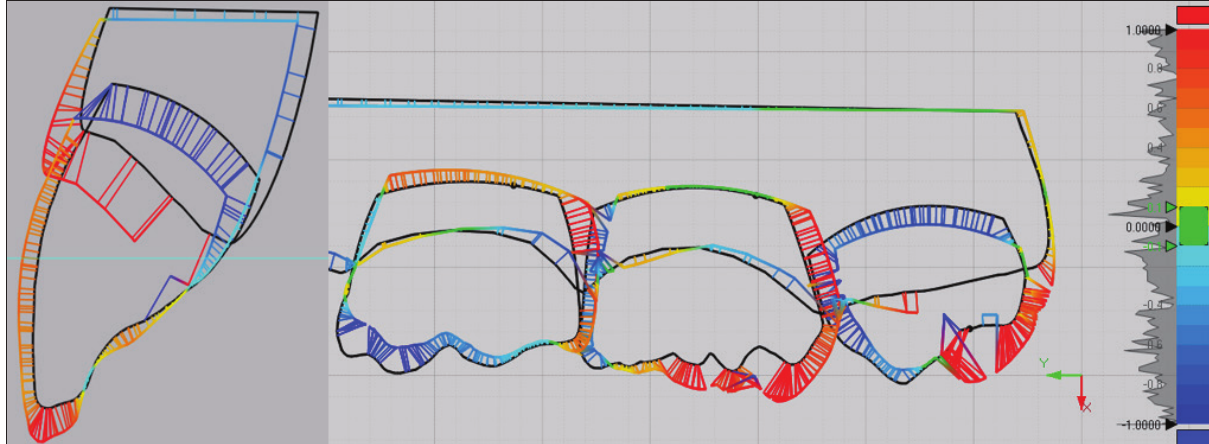
Figure 14. 2D slice of the upper left central incisor and the upper left buccal segment